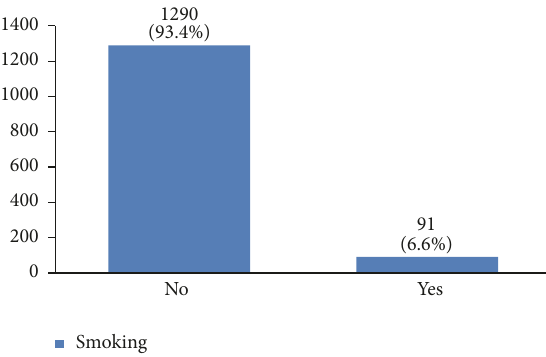
Figure 17: The tumor size of the studied breast cancer cases.